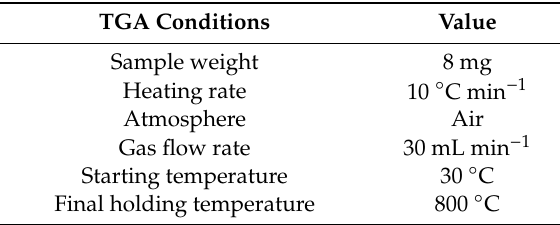
Table 2. Operating conditions for